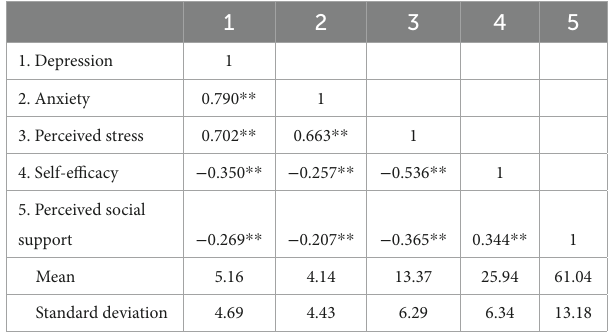
TABLE 1 Demographic characteristics and mood disorders of the participants ( N = 167).